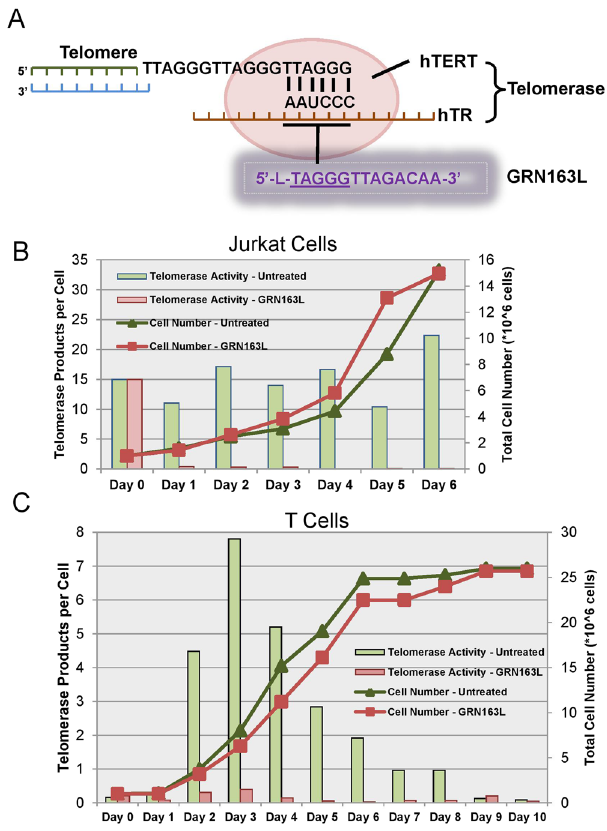
Figure 2. Inhibition of telomerase activity by GRN163L. ( A ) Schematic of GRN163L inhibition of telomerase activity. ( B ) Telomerase activity and cell growth curve of Jurkat cells treated with or without GRN163L. ( C ) Telomerase activity and cell growth curve of stimulated T cells treated with or without